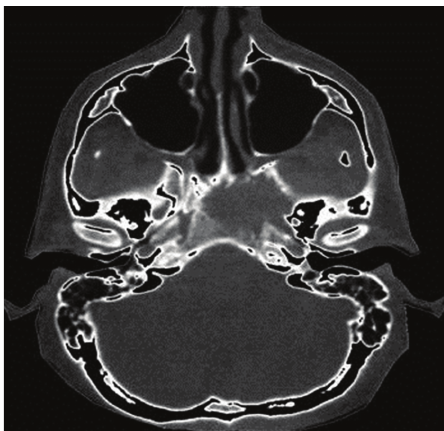
Figure 1: Cranial CT before radiotherapy.